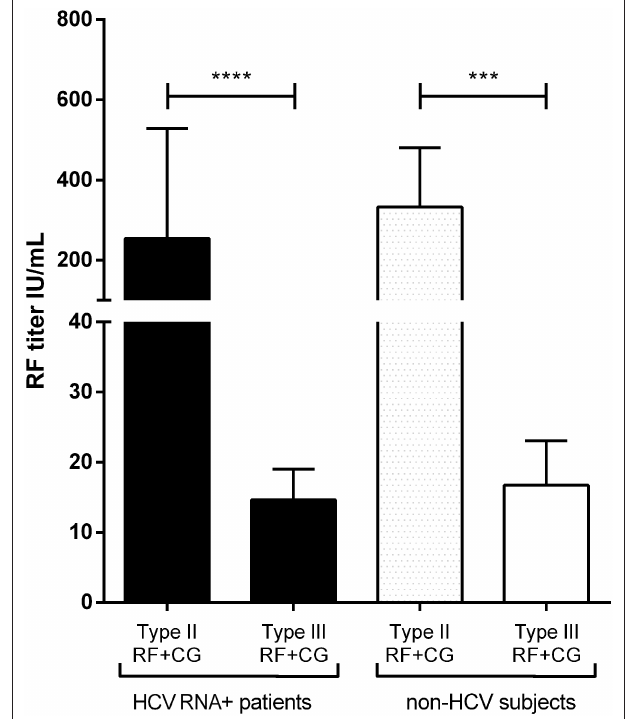
FIGURE 4 | Quantification of RF in HCV RNA + CG and non-HCV CG. Type II CG (29 HCV RNA + patients and 43 non-HCV subjects) and type III CG (24 HCV RNA + patients and 17 non-HCV subjects) (mean ± SEM, **** p < 0.0001; *** p = 0.0004).